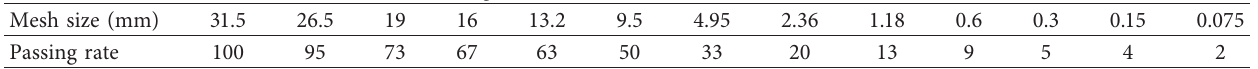
Figure 9: Cement-stabilized crushed stone beam mold. Table 6: The gradation of cement-stabilized crushed